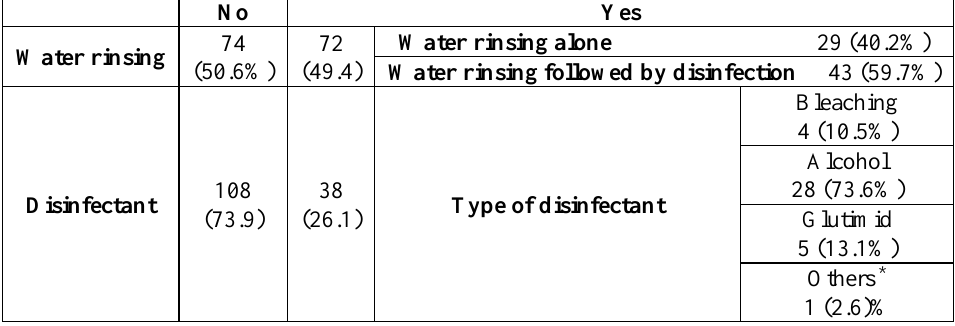
Table 6: Impression water rinsing and disinfection